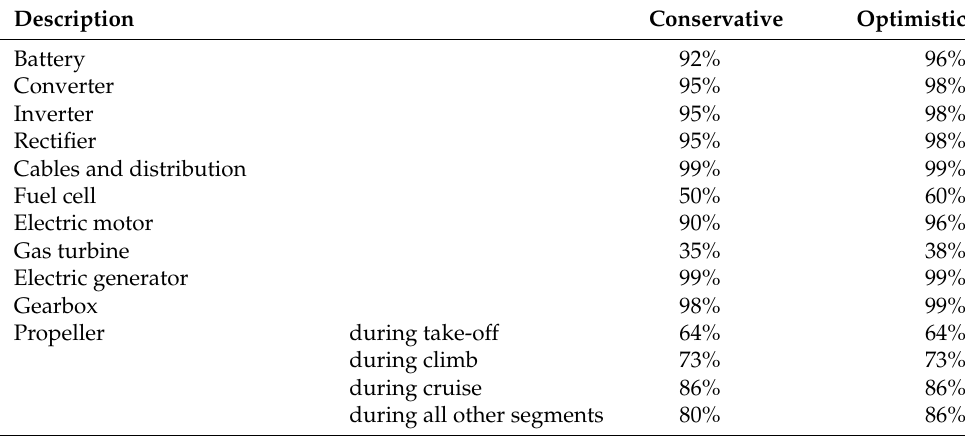
Table A1. Assumed efficiencies of powertrain components.